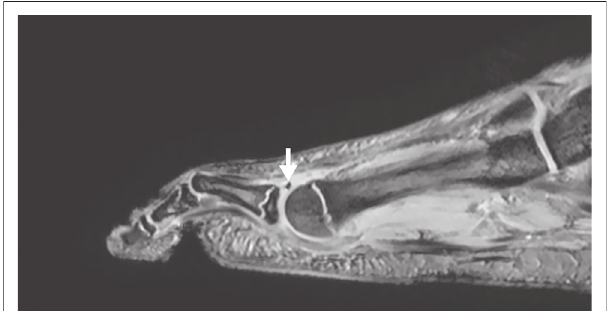
FIGURE 12: Sagittal gradient recalled echo (GRE) MR image of the foot demonstrating a foreign body (arrow) in the plantar aspect of the